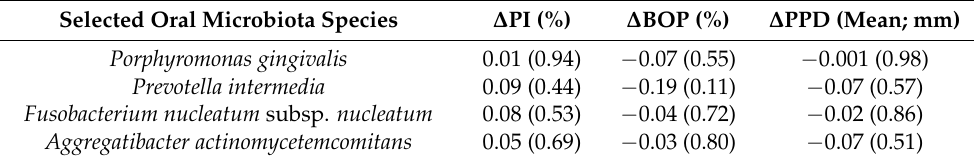
Table 2. Relationship of differences between pre- and post-treatment values of clinical parameters with representative bacterial species in the oral microbiota in patients ( n = 72) with periodontal disease. Selected Oral Microbiota Species ∆ PI (%) ∆ BOP